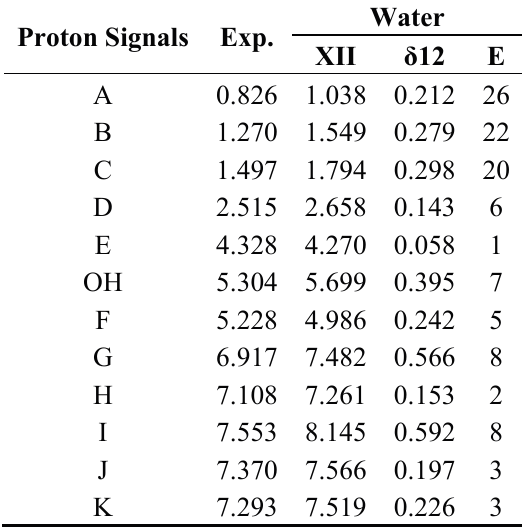
Table 4. Calculated and experimental data recorded at 293 K for losartan anion ( 1 ) Rotamer XIV (isomer anti ); the following parameters were determined for their proton groups: experimental (Exp.) and calculated values of the chemical shifts (XIV), absolute errors ( δ 14) and values of the relative percentage errors (E); calculated NMR shielding for proton H ref = 31.642 ppm for TMS (PBE1PBE/6-31G(d,p)/GIAO/CPCM; R 2 = 0.99, MAD = 0.37. Proton Signals